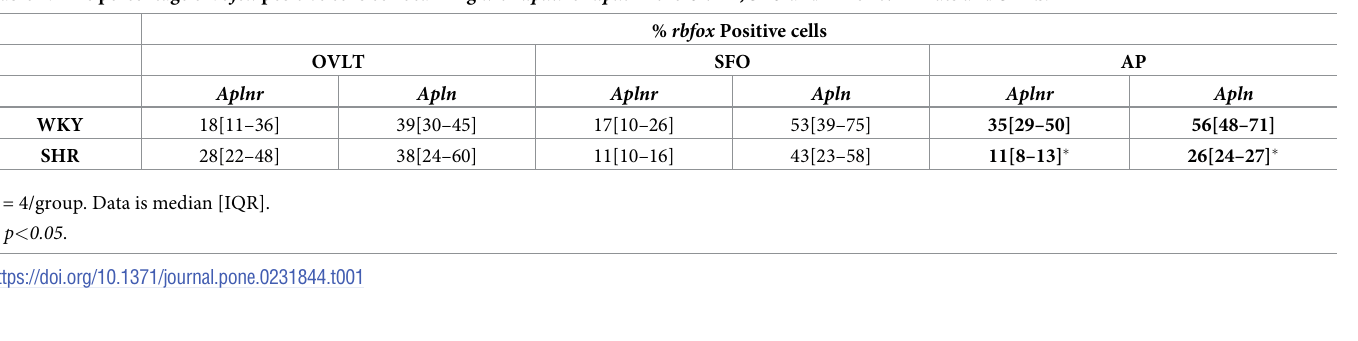
Table 1. The percentage of rbfox positive cells co-localizing with aplnr or apln in the OVLT, SFO and AP of WKY rats and